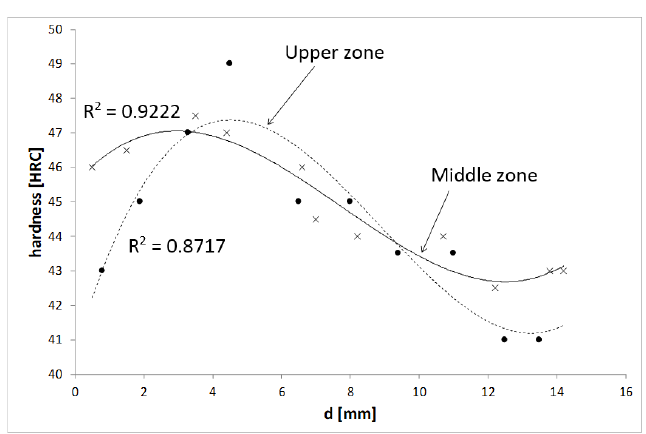
Figure 3. The 8620 steel deformed at 1100 °C, with hardness as a function of distance from the sur- face.